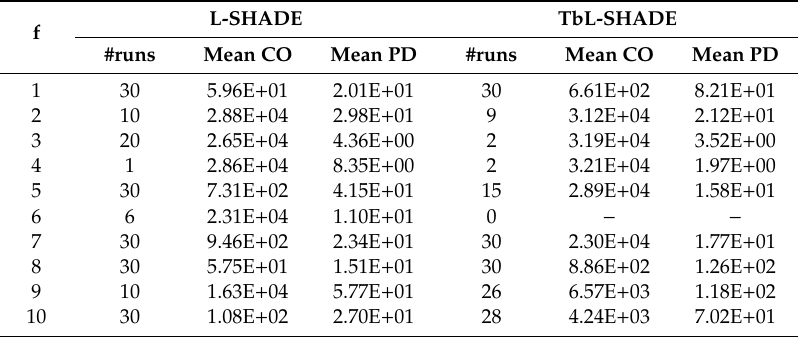
Table 28. Clustering and population diversity of L-SHADE and TbL-SHADE on the CEC2020 in 10 D .